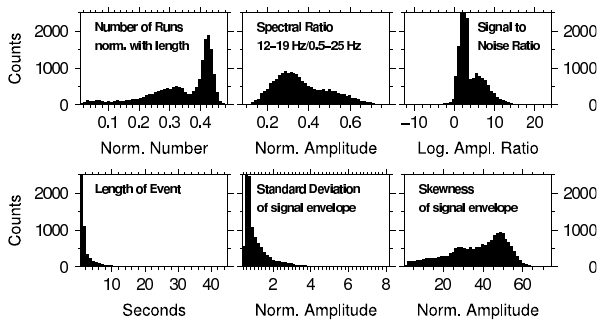
Fig. 2. Distribution of features forming input data vectors for clus- tering computed for all detected seismic events. Bimodal distribu- tions denote existence of